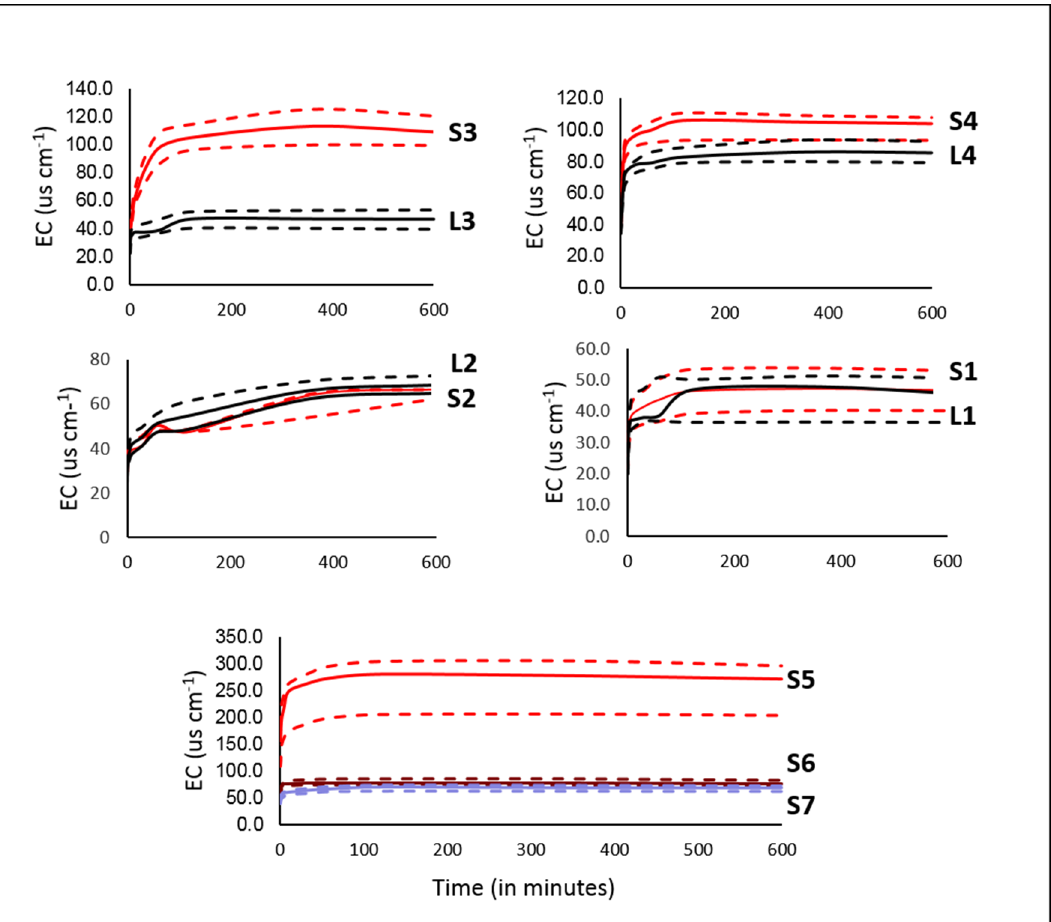
Figure 5. Result of the leaching test (electrical conductivity (EC) values) carried out on soil samples shown in Figure 2 from L1 to L4 (in dark) and S1 to S7 (from red to purple), presented as mean values (continuous line) together with standard deviations (as 1 σ ; dashed lines).